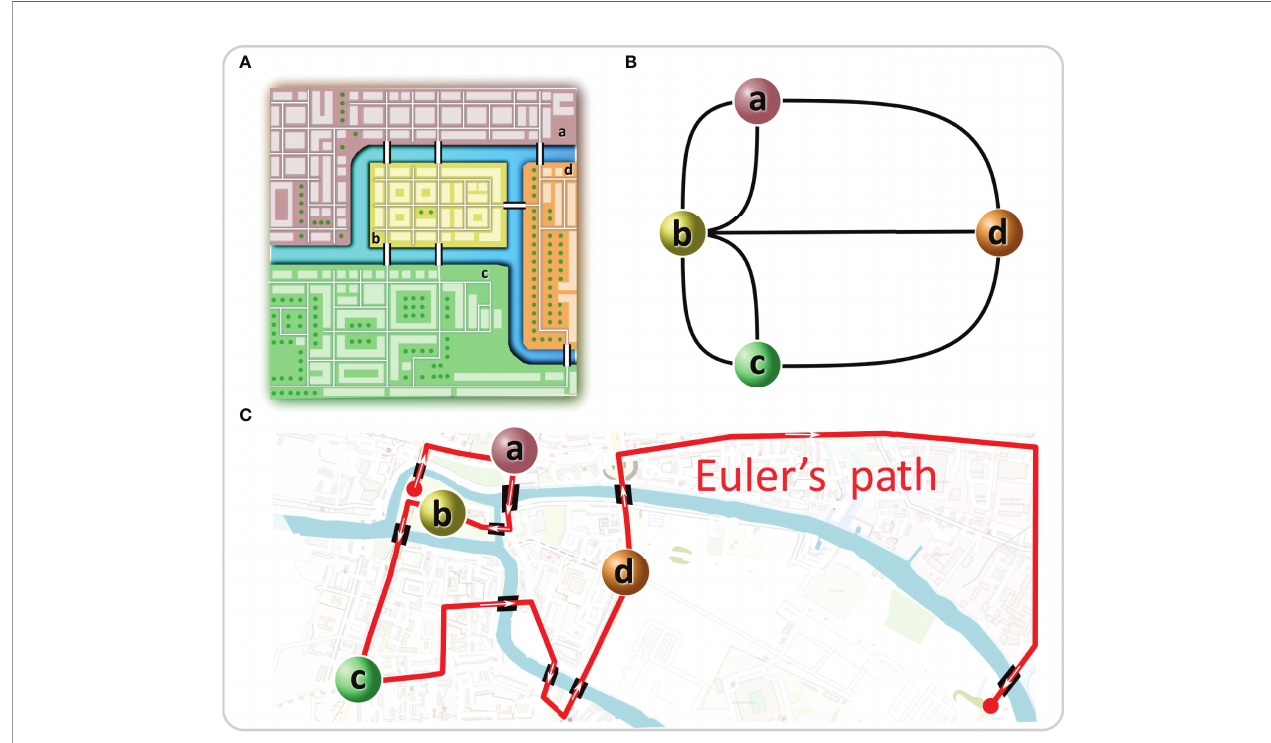
FIGURE 1 | The “ Königsberg bridge problem ” as a graph. (A) In Euler ’ s time, one part of Königsberg (a) was connected with two bridges to the smaller isle (b) in the Pregel River and with one bridge to the larger isle (d). The same was true for the other part of the city (c). The problem was to create a path that would cross each bridge only once. (B) Euler solved the problem by representing the system as a graph in which the isles were represented as nodes and the bridges as links between them. (C) Euler´s path is shown on the current map of